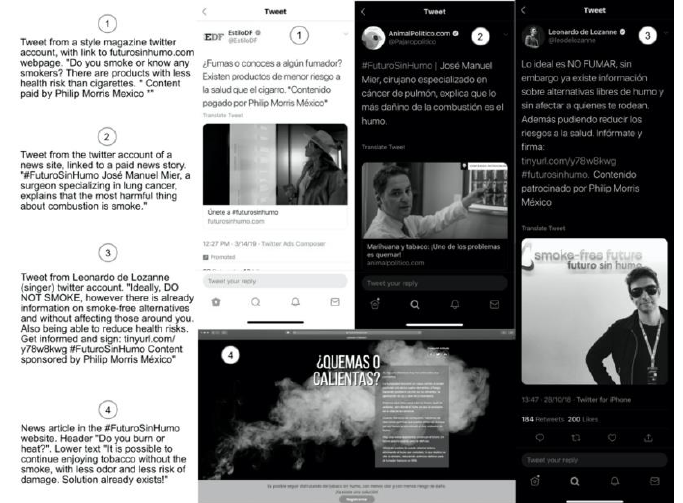
Figure 1. Examples of promotional materials use in Mexican social media.